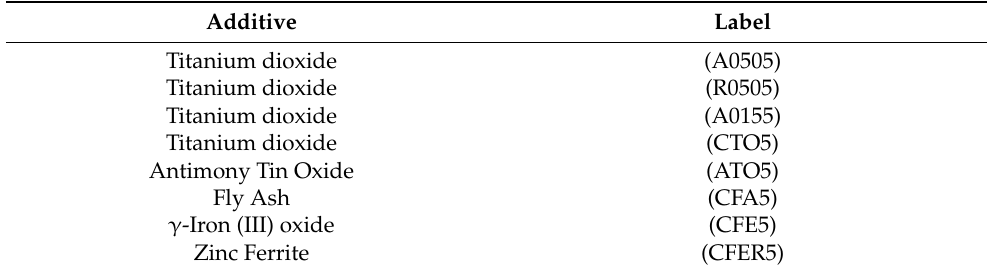
Table 4. Used additives and label used for them further in text.